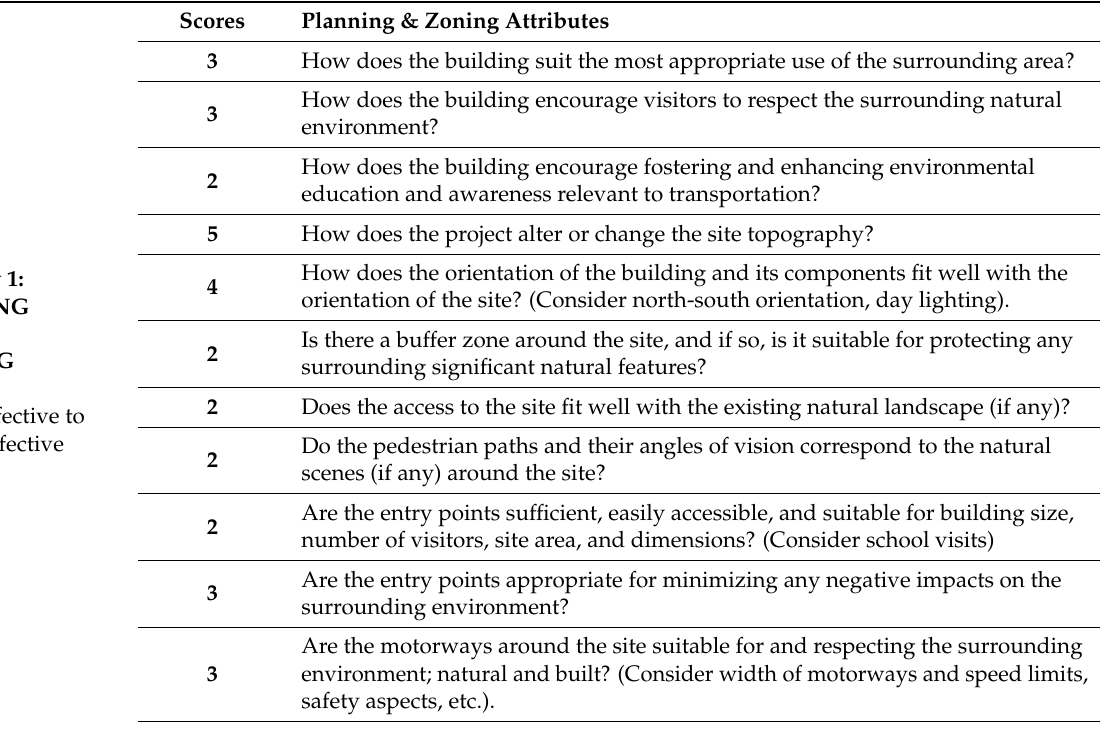
Table 5. Example of averaged scores utilizing the 6-point Likert Scale in assessing the category/factor of planning and zoning in Riverside Museum. (Some aspects of the tool have been utilized in other publications by the